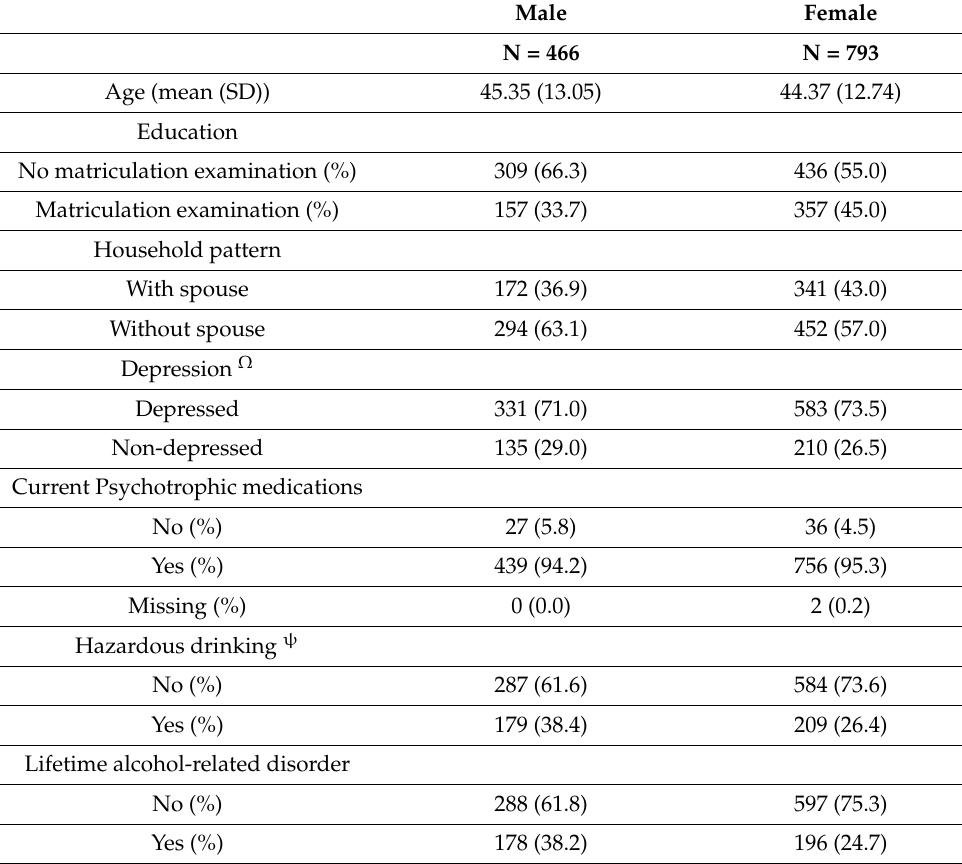
Table 1. Background factors and alcohol use patterns in persons with bipolar disorder.